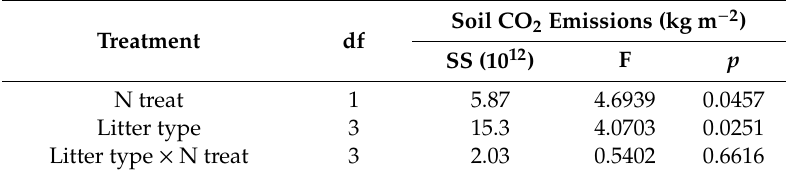
Table 3. The dependence of cumulative soil CO 2 emissions (kg m − 2 ) on N and fine root litter treatments in two-way analysis of variance.